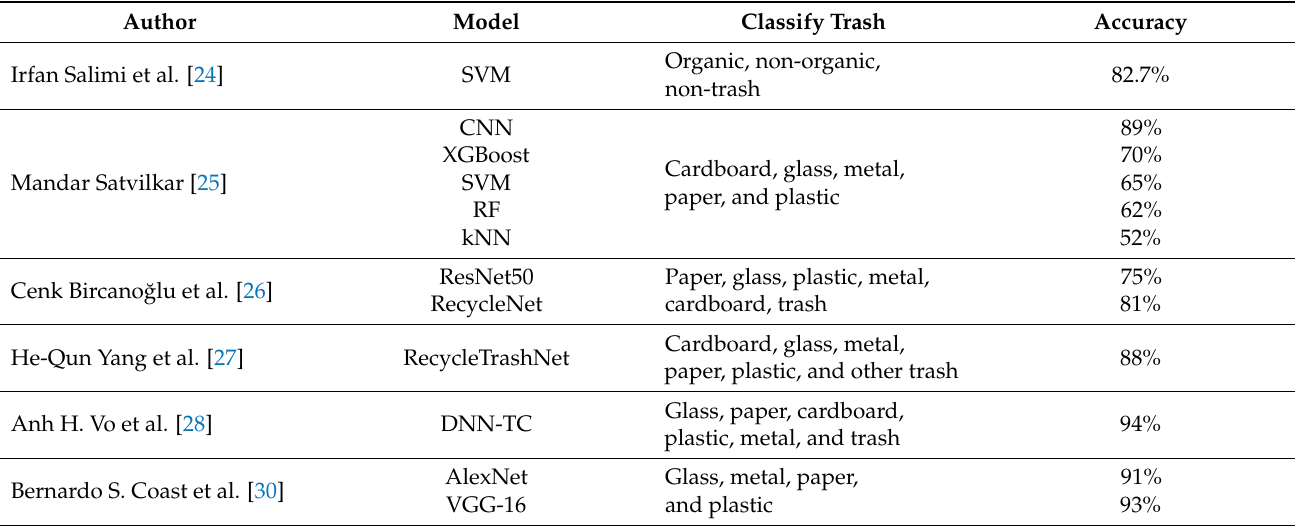
Table 4. Studies Related to Trash Image